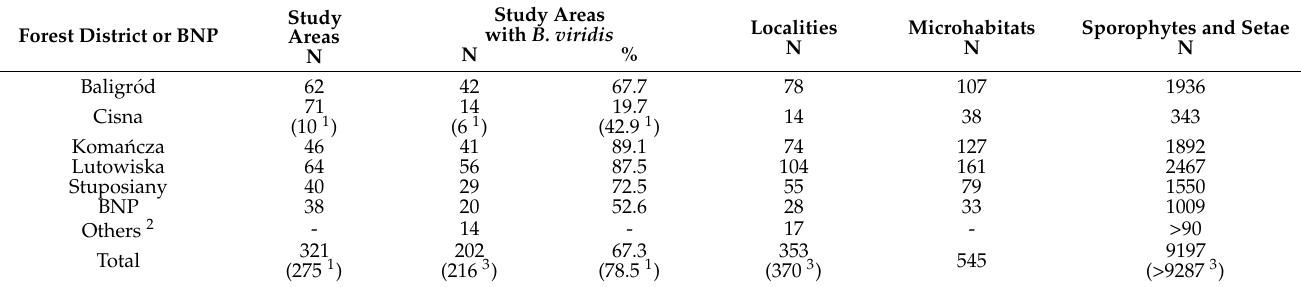
Table 1. Occurrence of Buxbaumia viridis in forest districts and in the Bieszczady National Park